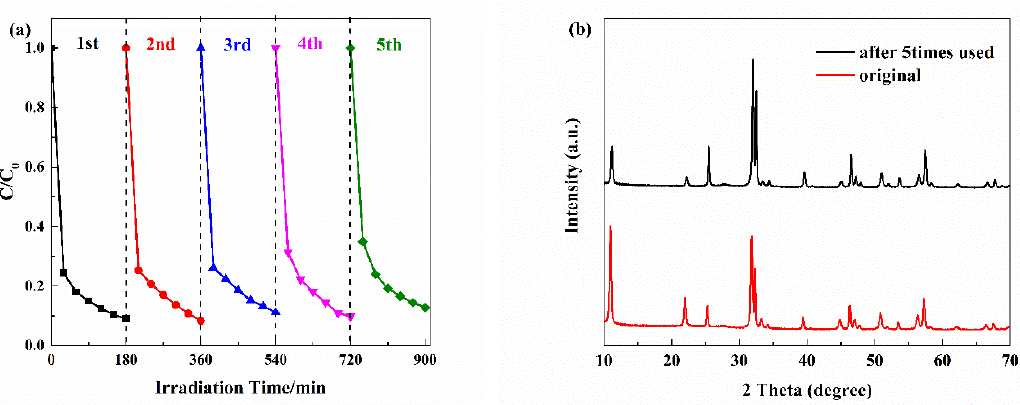
Figure 10. ( a ) Five cycles of experiments using samples with the best catalytic effect; ( b ) XRD patterns before and after the five cycles.